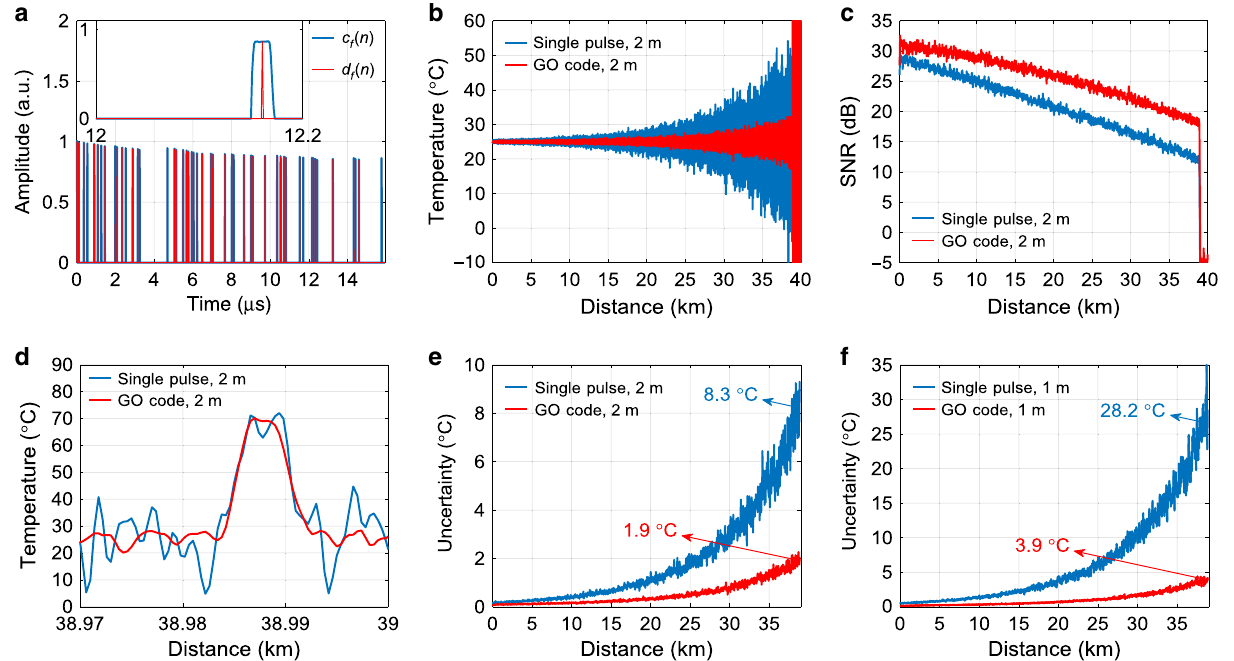
Fig. 4 Experimental results of GO-coded and single-pulse ROTDR. a A 177-bit normalised coding sequence c f ( n ) measured at the fi bre input (blue) and the retrieved d f ( n ) (red). Inset: Zoom-in of normalised c f ( n ) and d f ( n ) over a time span from 12 to 12.2 μ s. b Retrieved temperature pro fi les over the entire sensing fi bre, for single-pulse (blue) and GO-coded (red) schemes. c SNR pro fi les over the entire sensing fi bre, for single-pulse (blue) and GO-coded (red) schemes. d Retrieved temperature pro fi les around a 5-m-long hotspot located near the fi bre far-end. e , f Temperature uncertainty pro fi les along with the sensing fi bre for 2 and 1 m SRs.